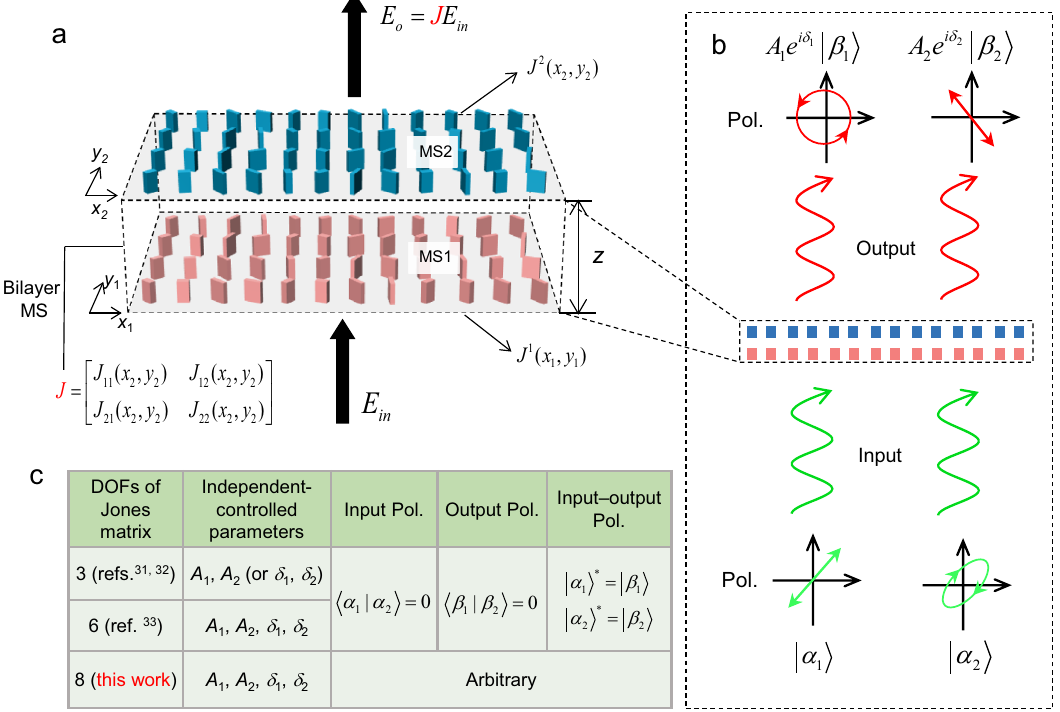
Fig. 1 | Jones matrix with eight DOFs and an application example of advanced light control. a Schematic view of a bilayer metasurface with eight DOFs in the Jonesmatrix.TheincidentandoutputJonesvectors E in and E o areconnectedby2×2 equivalentJonesmatrix J .Thetwolayermetasurfacesareseparatedbyadistance z . TheJonesmatrixofeachsinglelayerissymmetricandendowedwithsixDOFs.MS: metasurface. b Schematic of the bilayer metasurface for independent amplitude